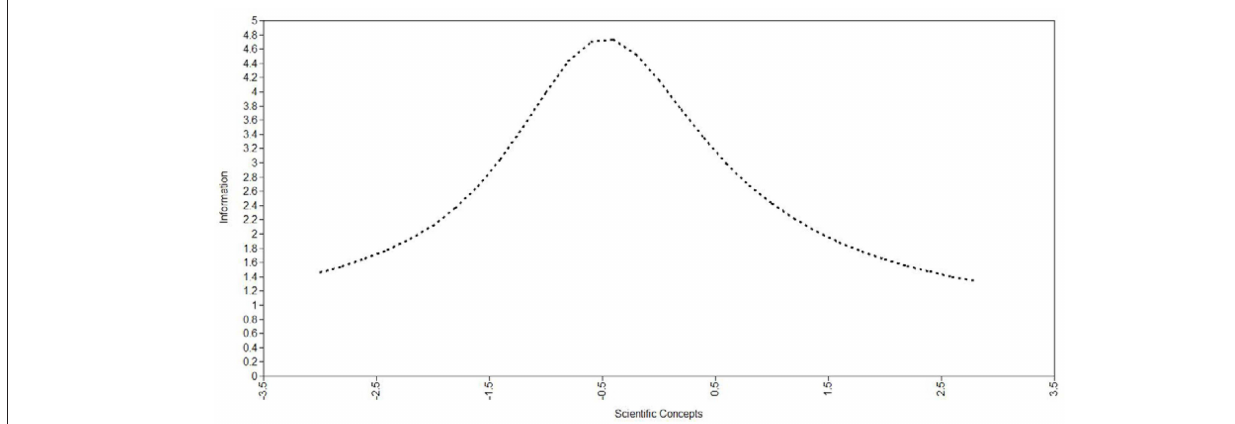
FIGURE 2 | SLA information function for the Scientific Inquiry Processes dimension.